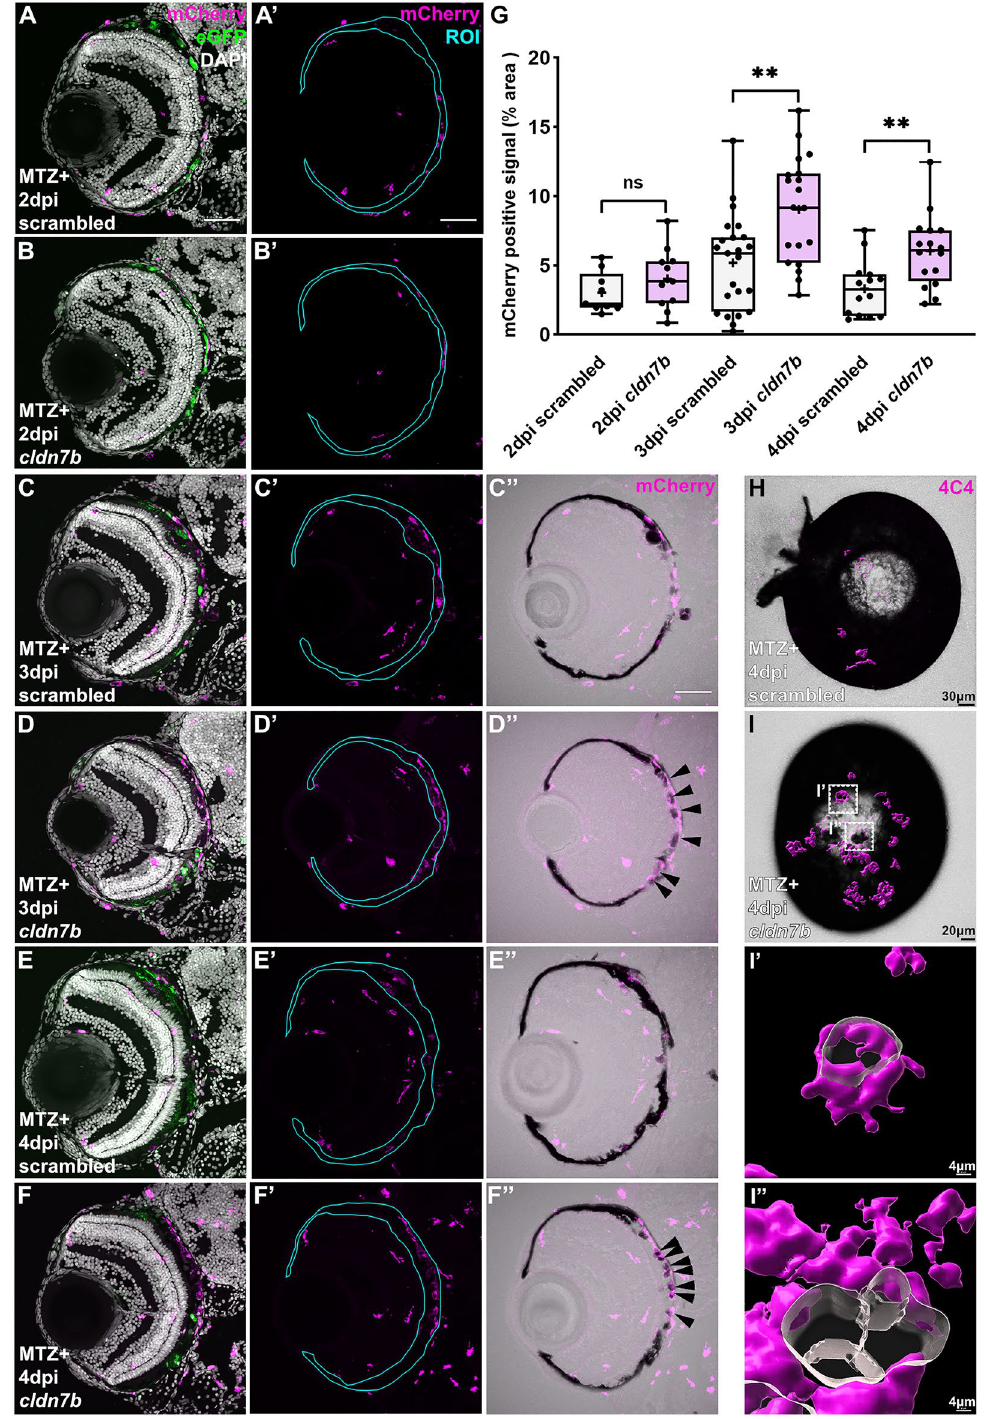
Figure 3. cldn7b F0 larvae show retention of macrophages/microglia and impaired clearance of pigment debris during RPE regeneration. ( A – F ) Representative immunofluorescence images of mCherry signal in ablated (MTZ +) scrambled and cldn7b F0 larvae at ( A , B ) 2dpi, ( C , D ) 3dpi, and ( E , F ) 4dpi. ( A’ – F’ ) Single-channel images of mCherry signal in RPE ROIs. ( C’’ – F’’ ) Overlay of mCherry and bright-field channels. Nuclei (white), eGFP (green), mCherry (magenta). ( G ) Box plots showing significantly more mCherry+ macrophage/microglia in the RPE layer of cldn7b F0 larvae at 3dpi and 4dpi, compared to scrambled controls. ( H , I ) Overlaid images of 3D-rendered 4C4+ isosurfaces (magenta) with brightfield channels from ablated scrambled and cldn7b knockout whole-mount eyes. 4C4+ macrophages/microglia (magenta) surfaces were 3D-rendered in Imaris. ( I’ , I’’ ) Zoom-in of (I; white boxes) cldn7b F0 whole-mount eye showing 4C4+ cells engulfing pigment debris. ( A – F ) Scale bars = 50 μm. ( H – I ) Scale bars were indicated on the images. ** p value ≤ 0.01; ns not significant. Exact p values, numbers of independent experiments (N), and numbers of biological replicates (n) can be found in Table S3. Abbreviations as follows: MTZ Metronidazole; dpi Days post-injury; ROI Region of